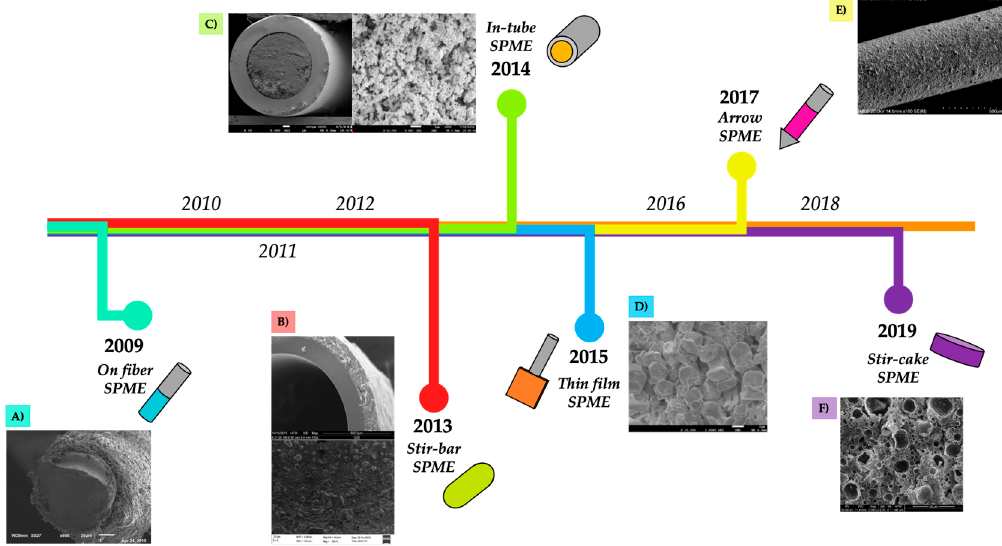
Figure 3. Timeline covering the introduction of MOFs as sorbents in the different solid-phase microextraction devices and configurations. ( A ) Adapted from [47], with permission from Elsevier, 2016. ( B ) Adapted from [48], with permission from Elsevier, 2016. ( C ) Adapted from [49], with permission from American Chemical Society, 2016. ( D ) Adapted from [50], with permission from Elsevier, 2018. ( E ) Adapted from [51], with permission from Elsevier, 2017. ( F ) Adapted from [52], with permission from Springer Nature,